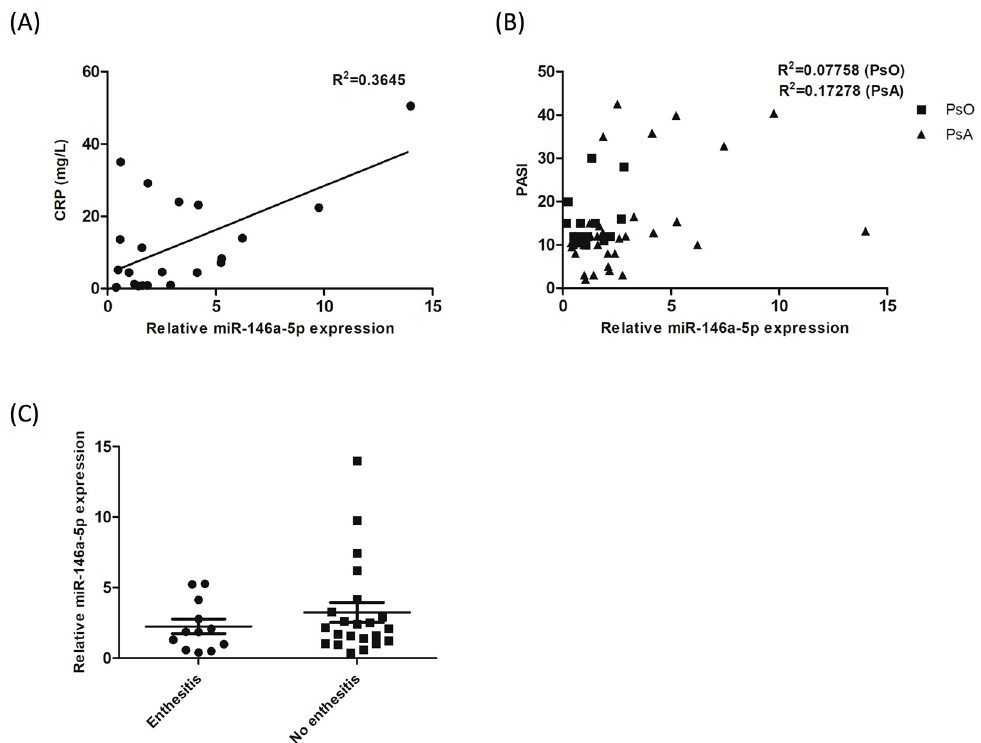
Figure 5. miR-146a-5p expression in CD14 + monocytes from PsA patients correlated to blood CRP level, but not the PASI score nor the presence of enthesitis. miR-146a-5p expression levels were measured in CD14 + monocytes from PsA and PsO patients. ( A ) CRP levels were measured in patients with PsA ( n = 22). miR-146a-5p expression correlation with CRP levels was analyzed using the Pearson correlation coefficient. ( B ) The PASI severity score was measured in 34 PsA patients, and 17 PsO patients. The correlation of miR-146a-5p expression with PASI was analyzed using the Pearson correlation coefficient. ( C ) The presence of enthesitis was evaluated in 34 PsA patients. The expression of miR-146a-5p in patients with or without enthesitis was evaluated using a Student’s t -test.